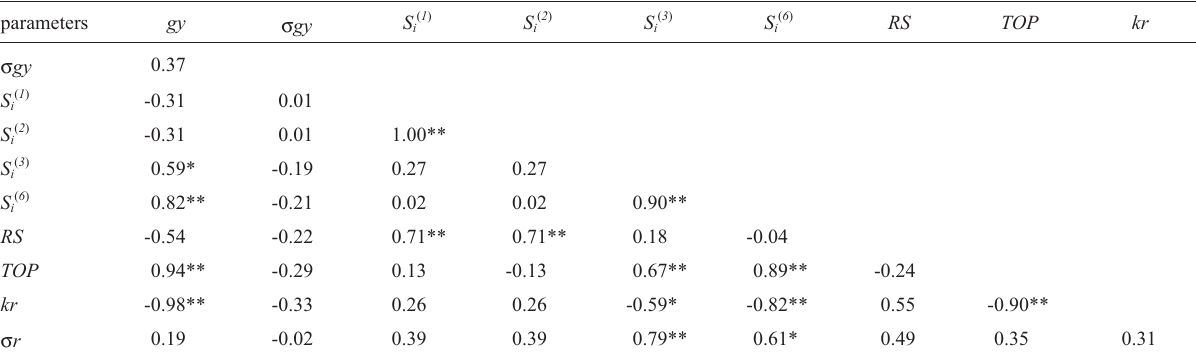
Table4 -Spearman’srankcorrelationcoefficientsbetweenthedifferentnonparametricstabilityparametersforgrainyieldof10breadwheatgenotypes.